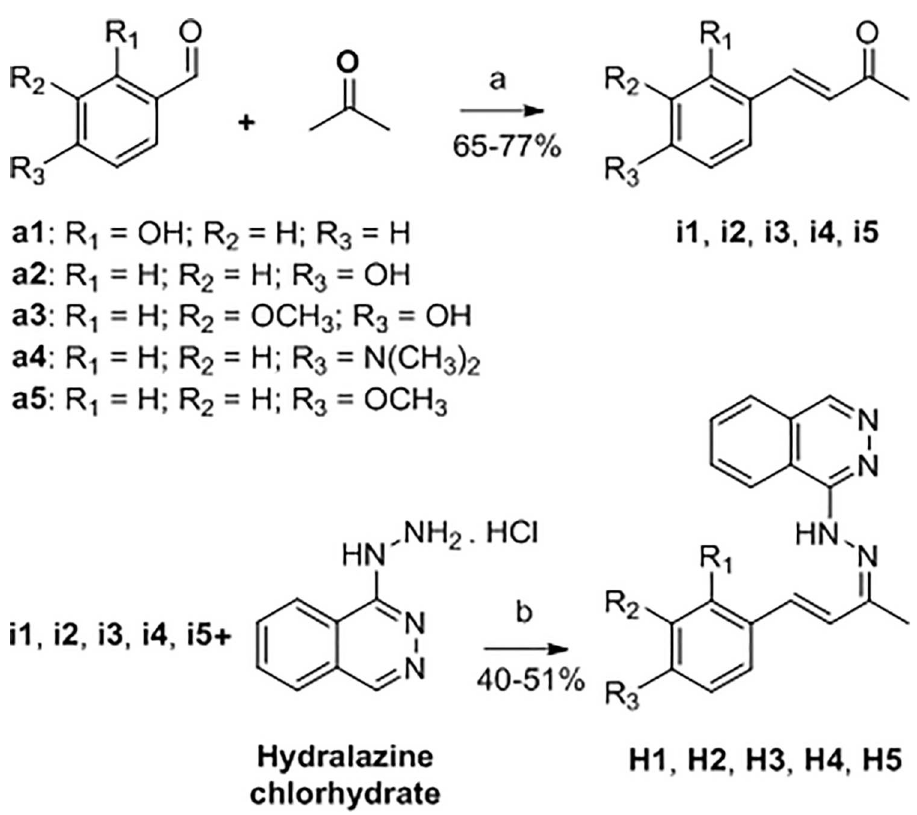
Fig 1. Synthetic route for hydrazone derivatives